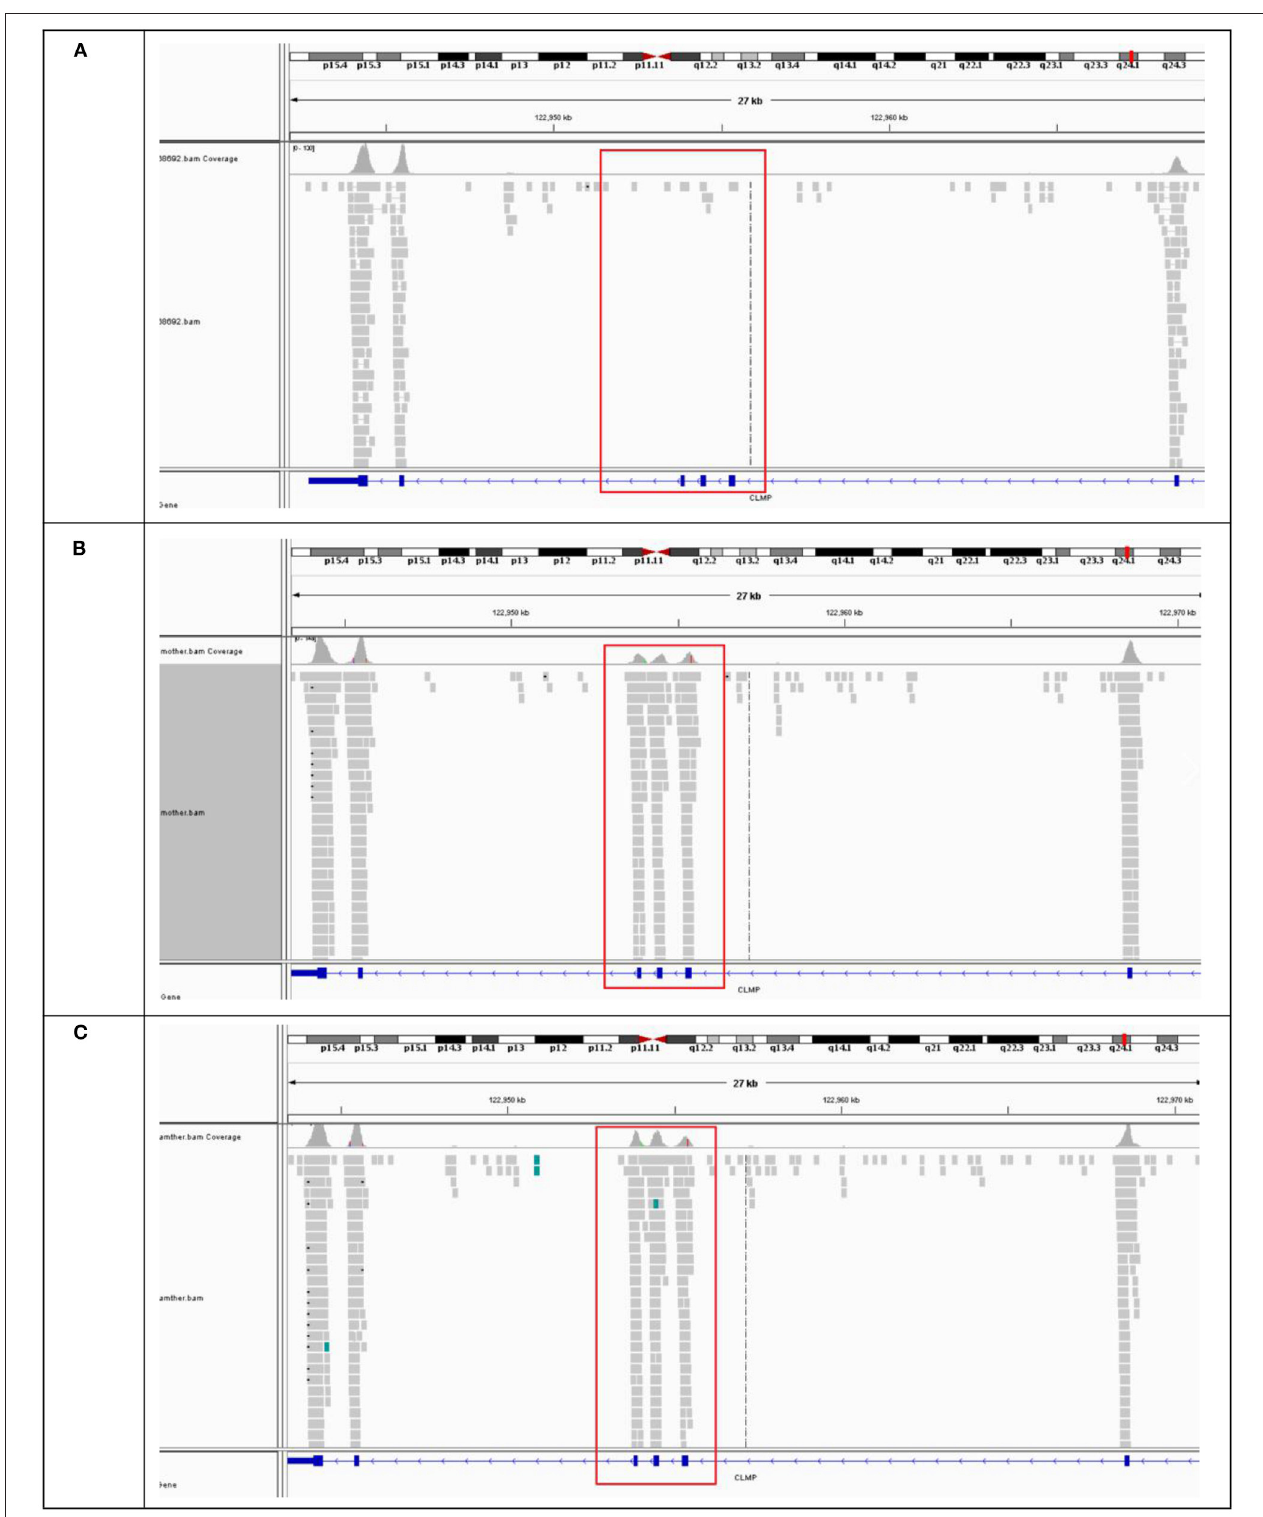
FIGURE 3 | BAM map of CLMP gene sequenced in proband and family. (A) The BAM mape of the proband and (B,C) BAM mapes of proband’s father and mother.